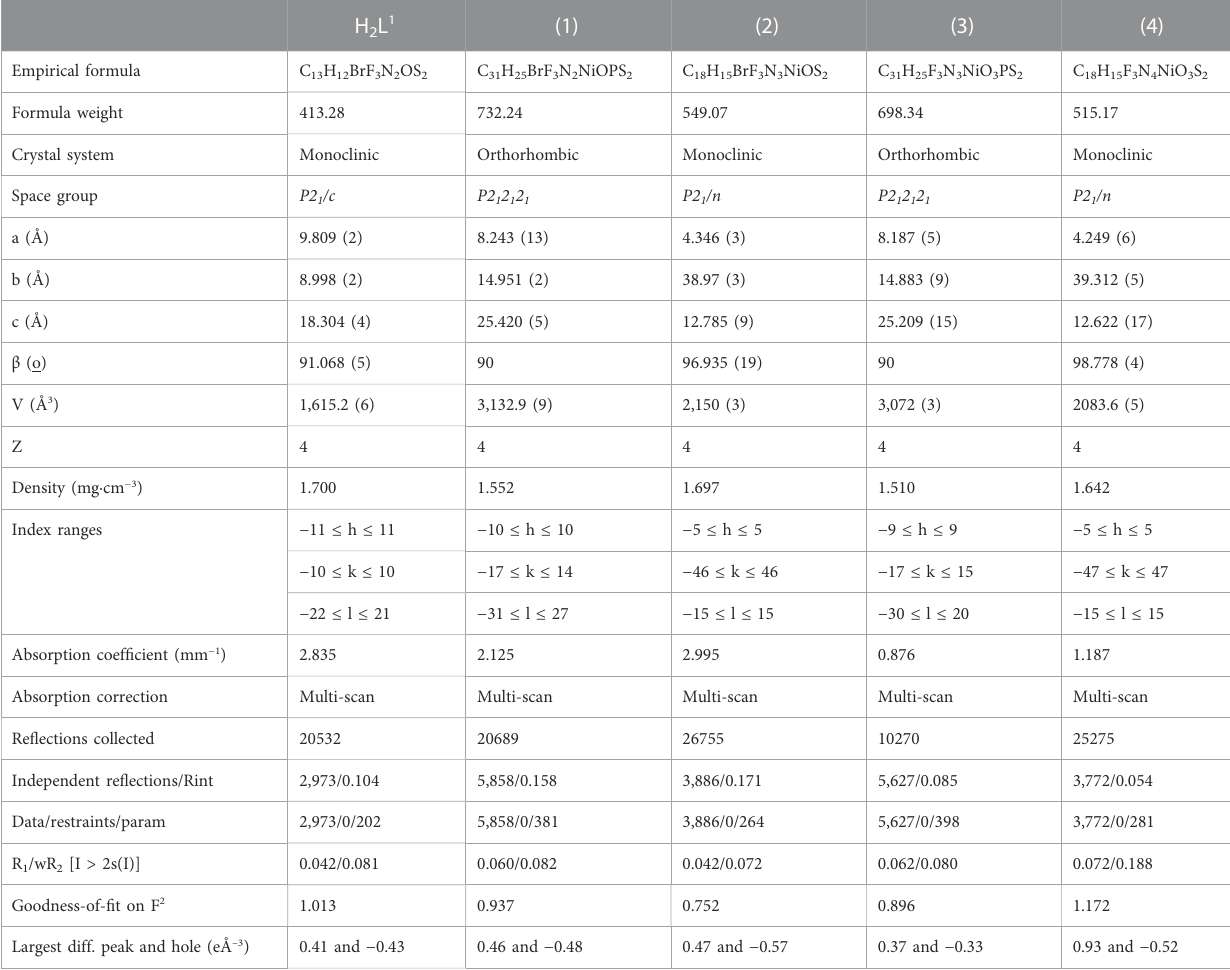
TABLE 1 X-ray diffraction data collection and re fi nement parameters for the ligand H 2 L 1 and the complexes (1 –